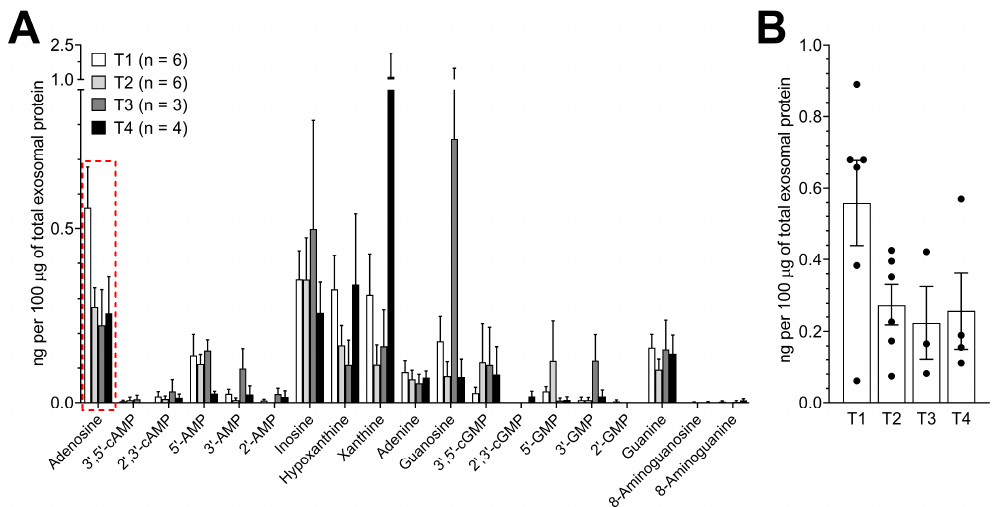
Next, the levels of purine metabolites in the panel of plasma-derived exosomes from HNSCC patients were correlated with the available clinicopathologic data. Using the tumor extension as a